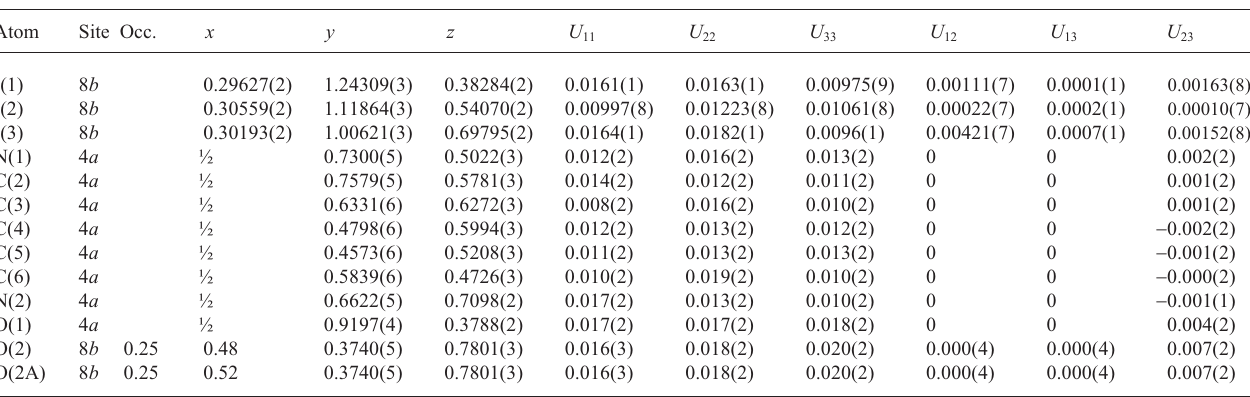
Table 3. Atomic coordinates and displacement parameters (in Å 2 ) .